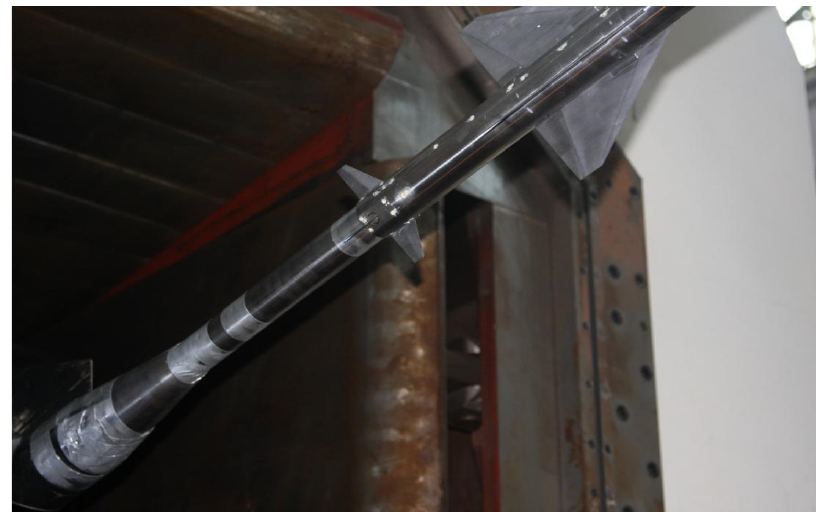
Figure 7. Support sting in wind tunnel test. (4) Comparative analysis DATCOM, CFD simulations, and wind tunnel tests determined the axial force coef- ficient ( CA ), normal force coefficient ( CN ), and pressure core coefficient ( Xp ) of the axisymmetric vehicle, as shown in Figures 8 and 9.